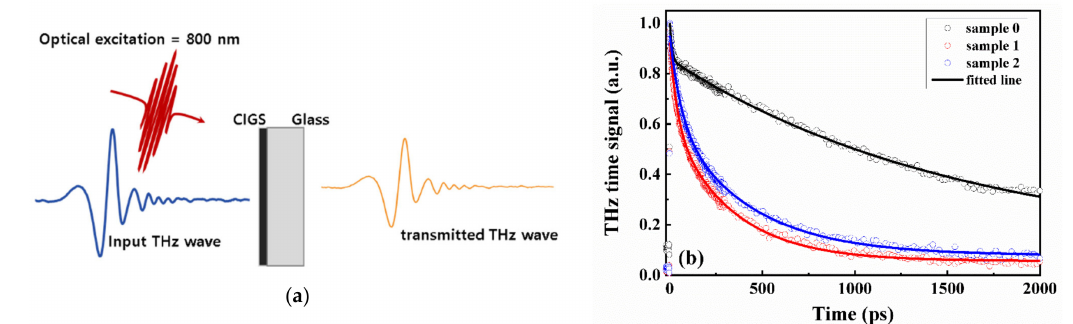
Figure 4. ( a ) Scheme of optical pump THz probe measurement and ( b ) the decay of amplitudes of transmitted THz wave through samples measured by optical pump THz